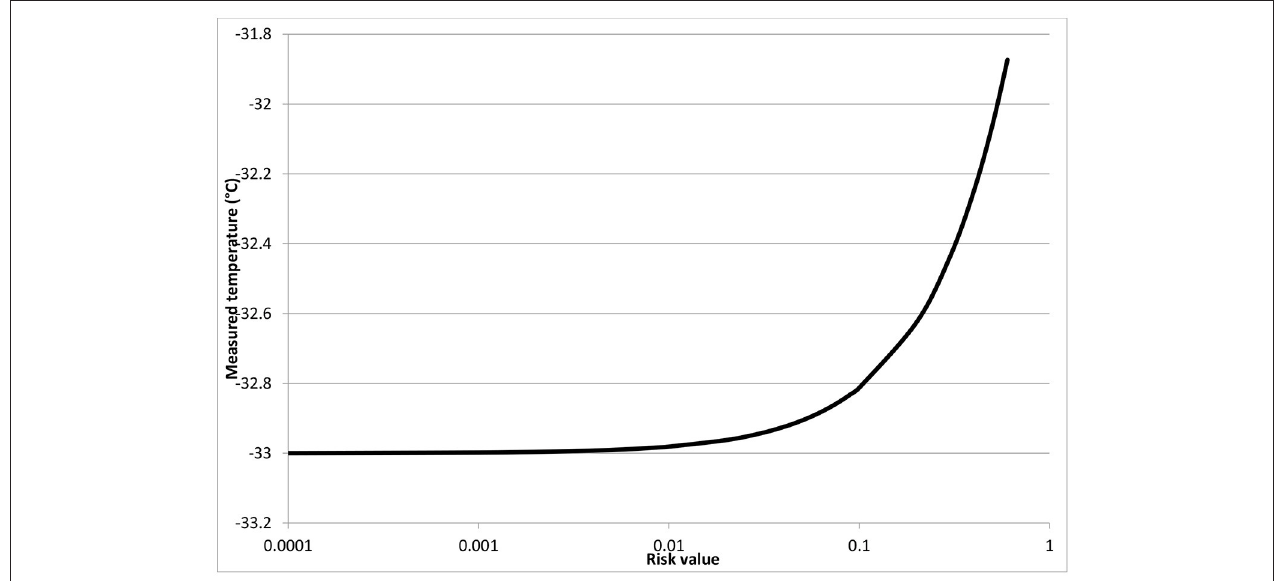
FIGURE 8 | Risk profile for the sucrose freeze-drying in the case under